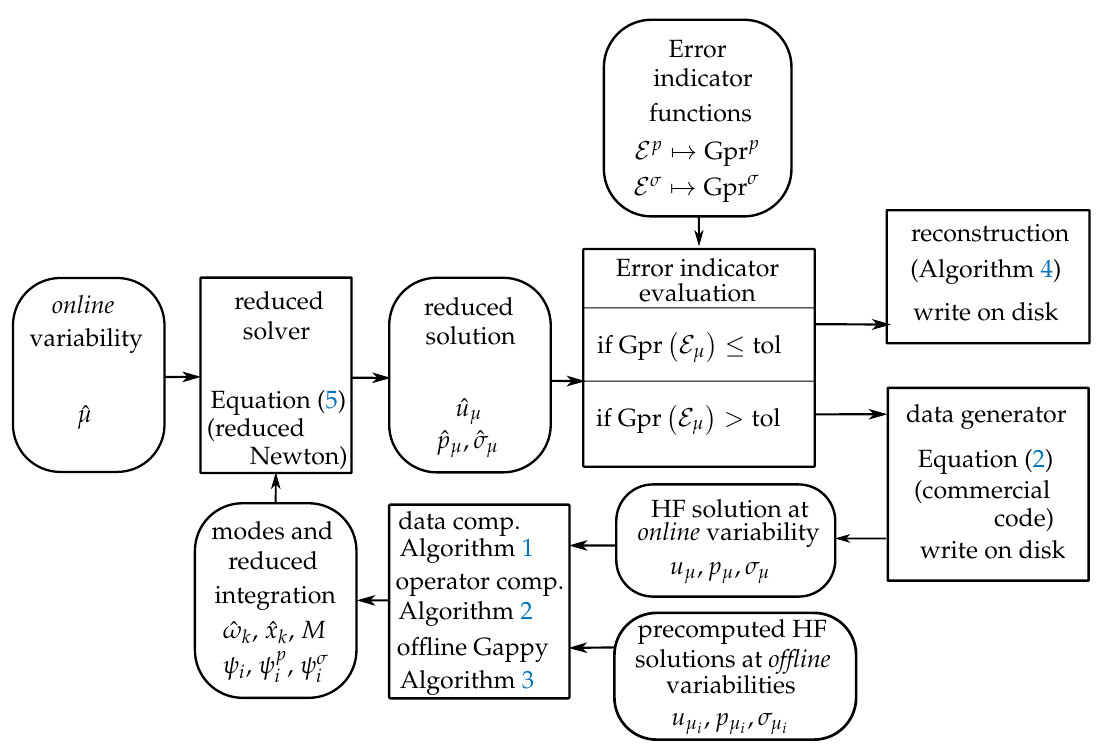
Figure 4. Workflow for the online stage with